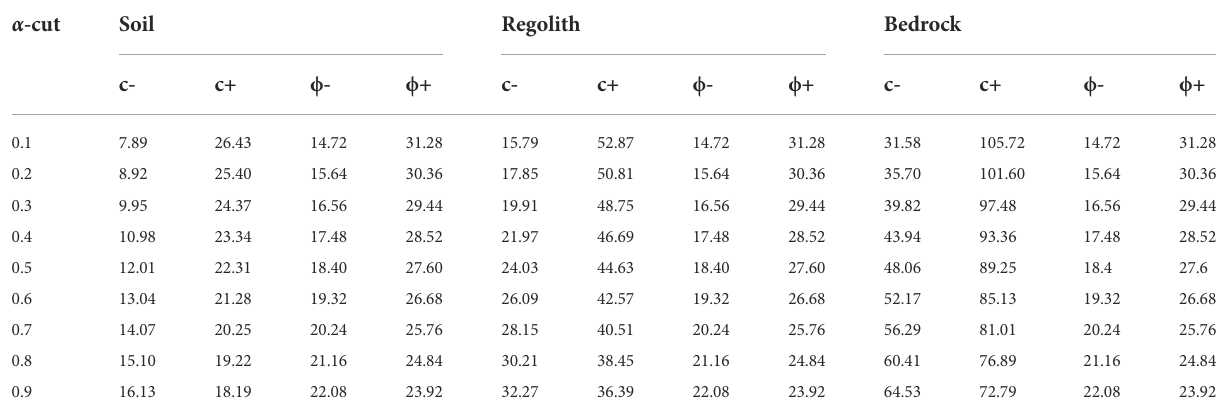
TABLE 2 The value of cohesion and friction angle of three geological materials in this study.